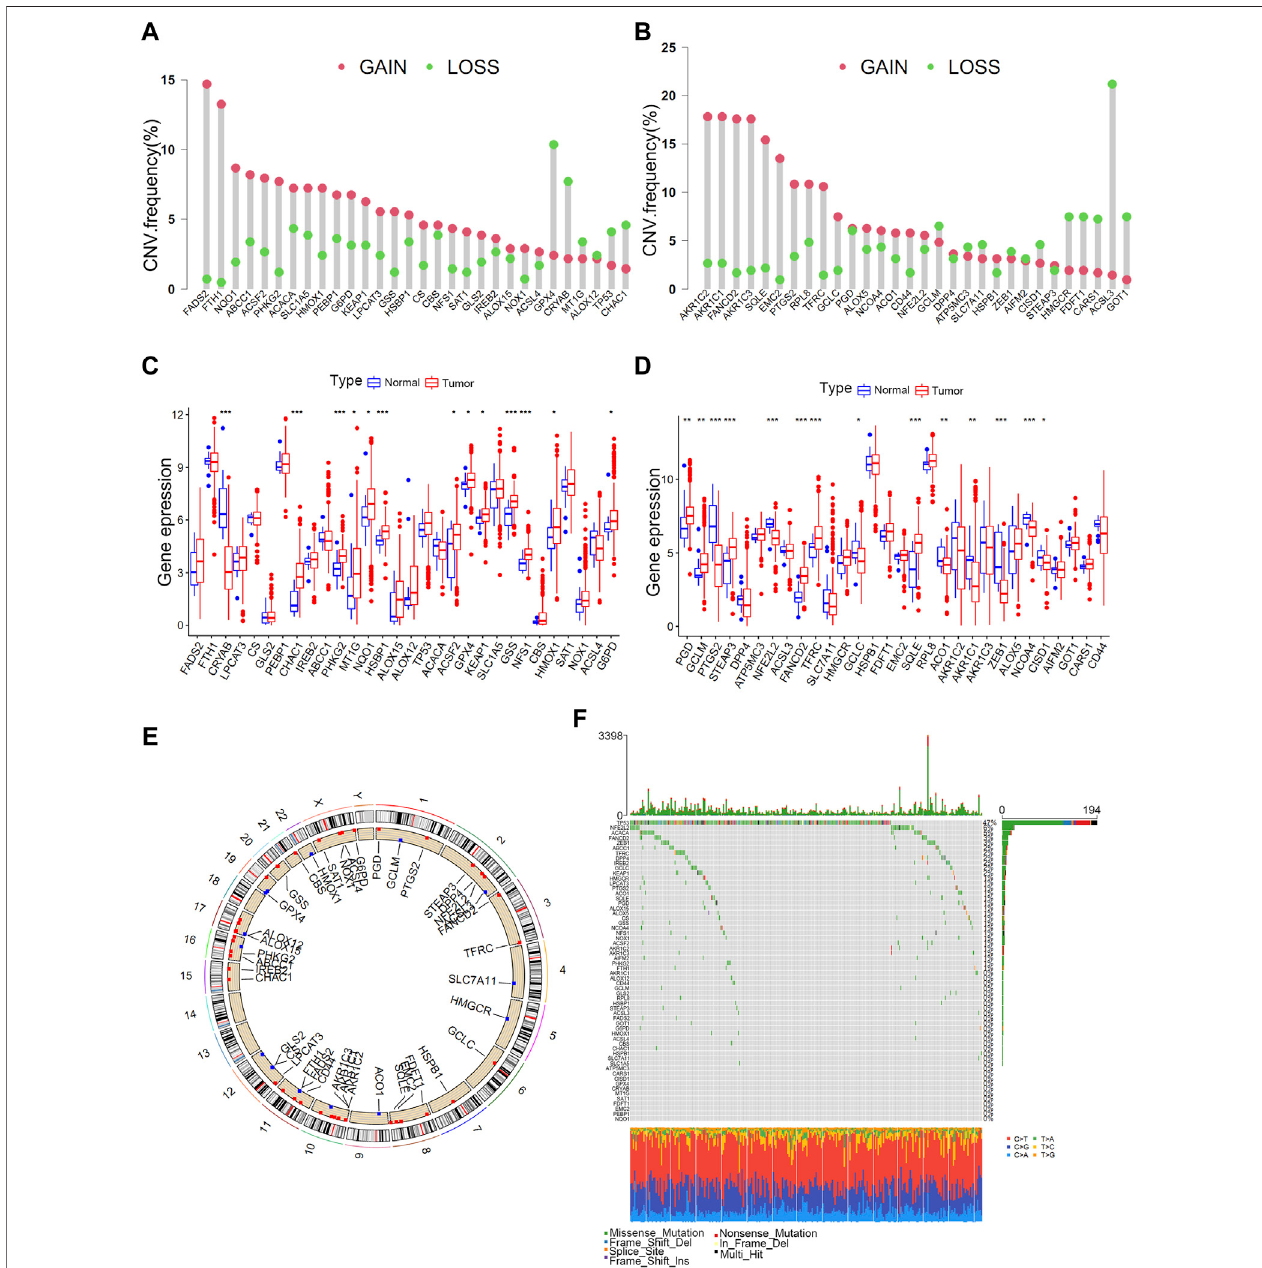
FIGURE1| Landscapeofgeneticvariationsinferroptosis-relatedgenesinbladdertumours. (A) CNVdistributions offerroptosis-relatedgenesinbladdertumours. (B) CNV distributions of ferroptosis-related genes in bladder tumours. (C) Different expressions of ferroptosis-related genes in tumour and normal tissues. (D) Different expressions of ferroptosis-related genes in tumour and normal tissues. (E) CNV locations of ferroptosis-related genes on 23 human chromosomes. (F) Waterfall plot demonstrating the somatic mutation status of ferroptosis-related genes in bladder cancer. Each column indicates individual samples, and the upper bar plot represents the TMB value. The number on the right represents the frequency of somatic mutations.